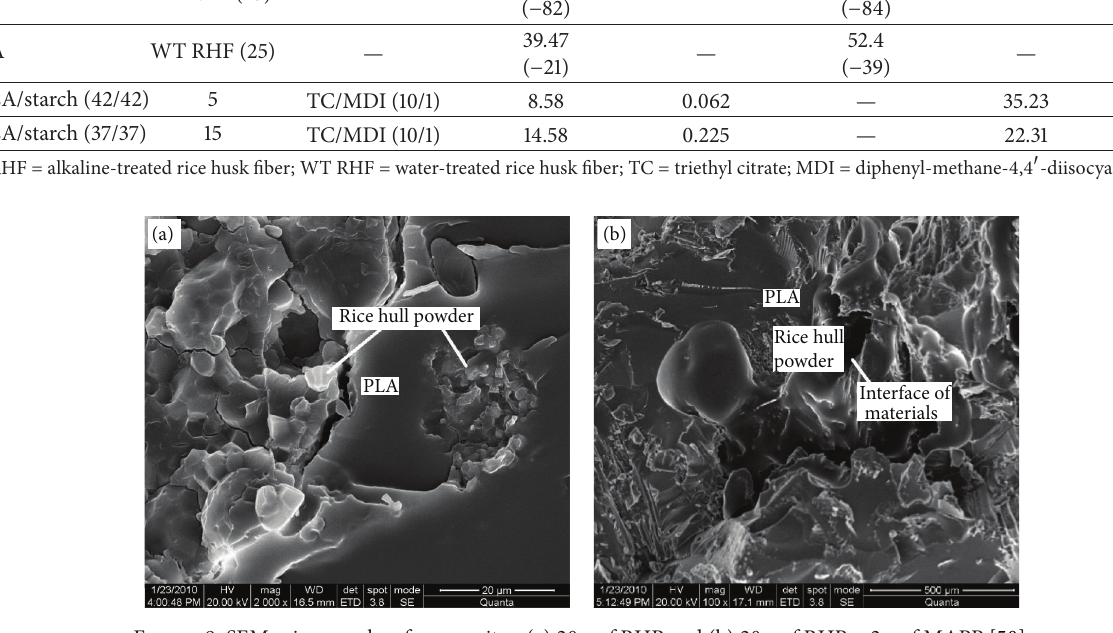
Figure 9: SEM micrographs of composites: (a) 20 g of RHP and (b) 20 g of RHP + 2 g of MAPP